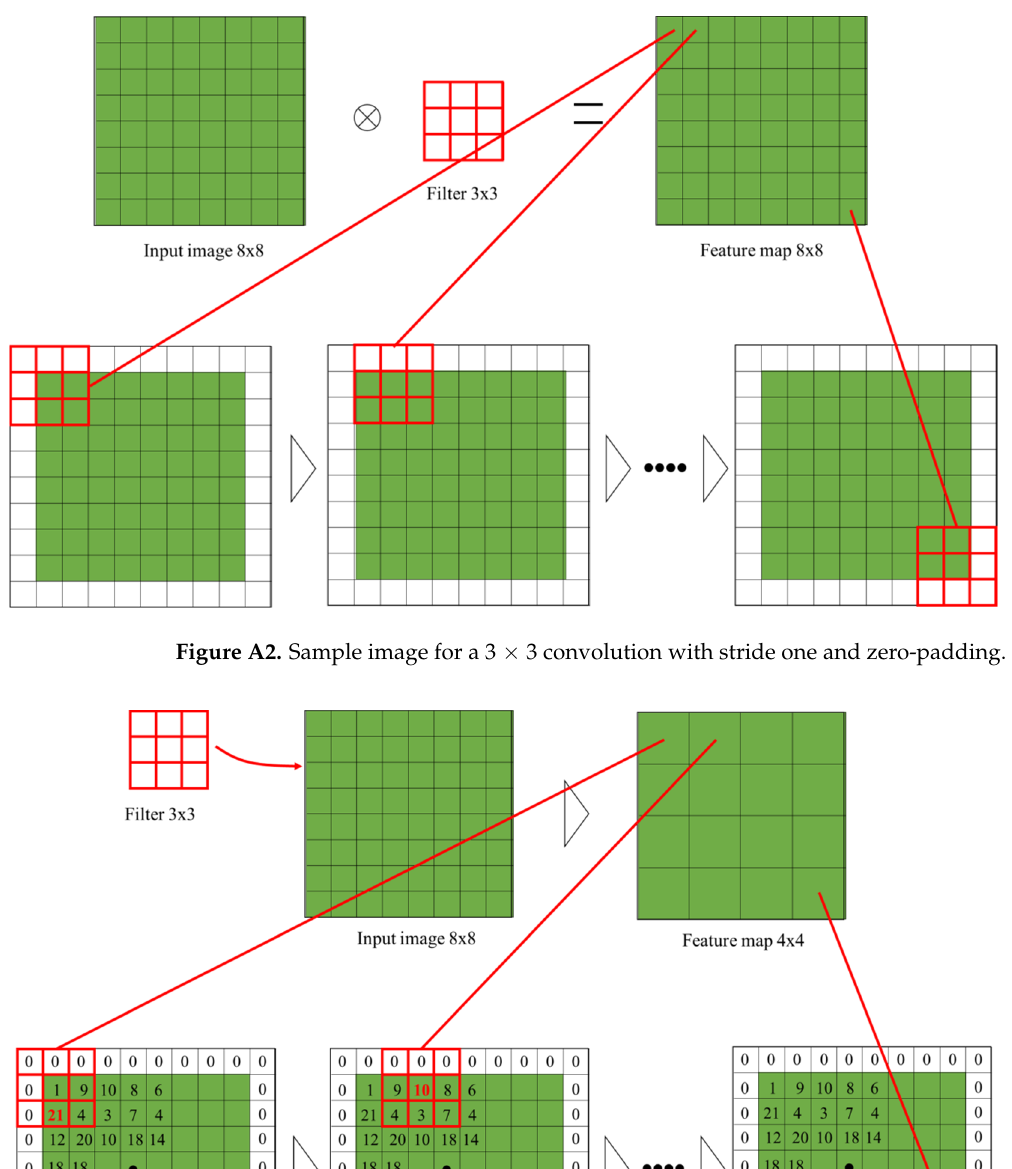
Figure A1. Dependency on the training number for W0.9 δ for the five-class classification problem.